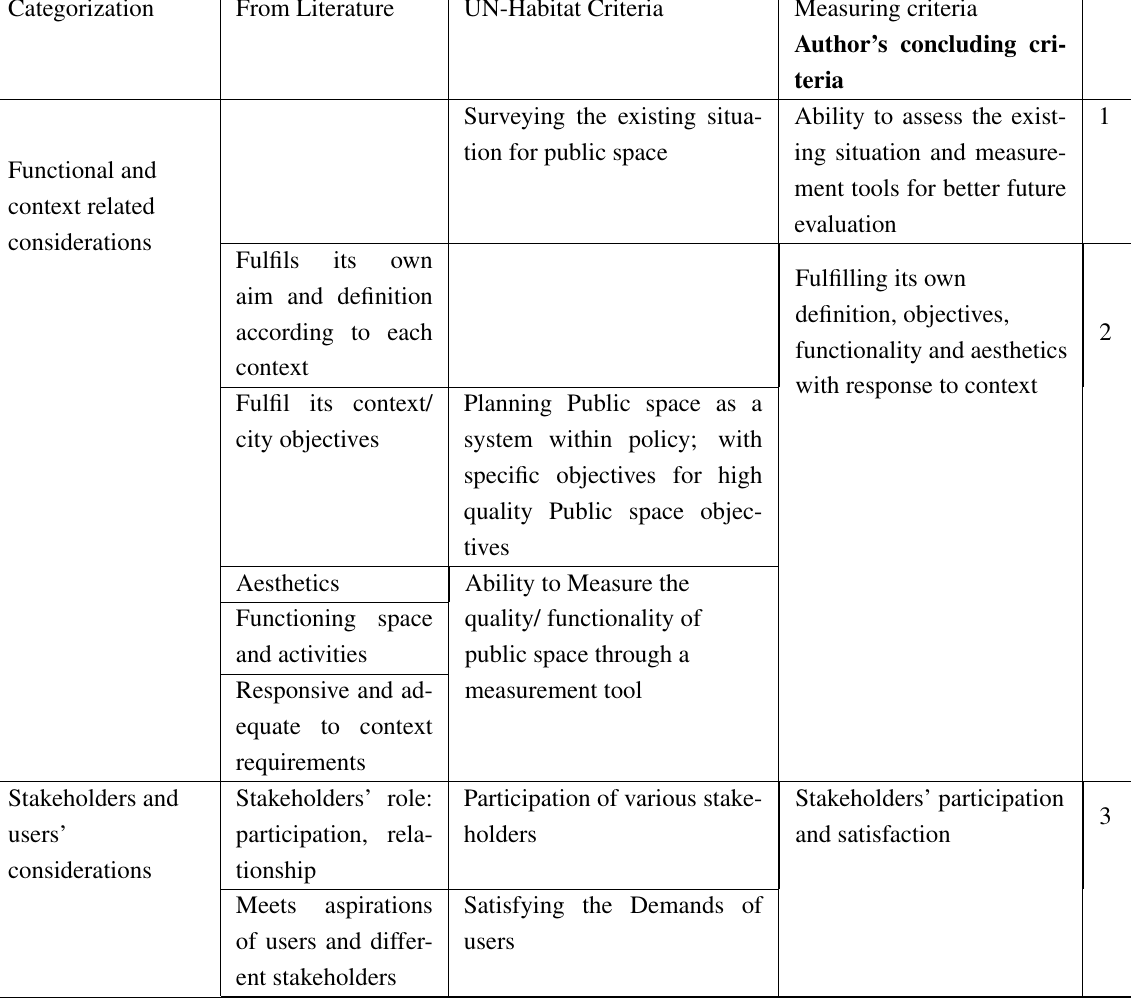
Table 2. Categorizing and Summerizing the Urban Design success criteria from literature, and UN-HabitatAuthors based on (Habitat III policy unit, 2016; UN-Habitat, 2016; UN-Habitat, 2013; Steino, 2003; CABE, 2003; Carmona, de Magalh˜aes, Edwards, Awor, & Aminossehe, 2001; Carmona M. , 2010; Sternberg, 2000; Macdonald, 2016; Moughtin, Cuesta, Sarris, & Paola, 1999) (Jones, 2006; Knox & Ozolins, 2000; Lang, 2005; Washburn,